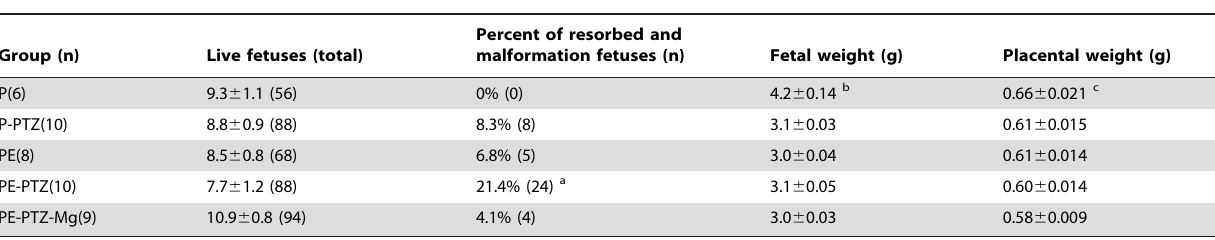
Table 4. Pregnancy outcomes in different groups on GD